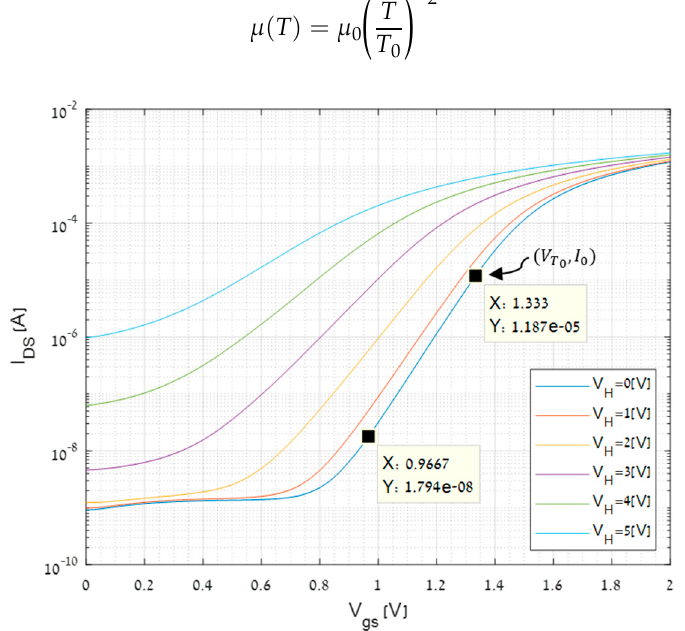
Figure 8. Current-voltage characteristics of the integrated TMOS (see Figure 1c) as a function of the voltage applied to the heating resistor. The current is plotted on a logarithmic scale. The relatively flat region before the exponential increase of the current is the leakage current, which increases with